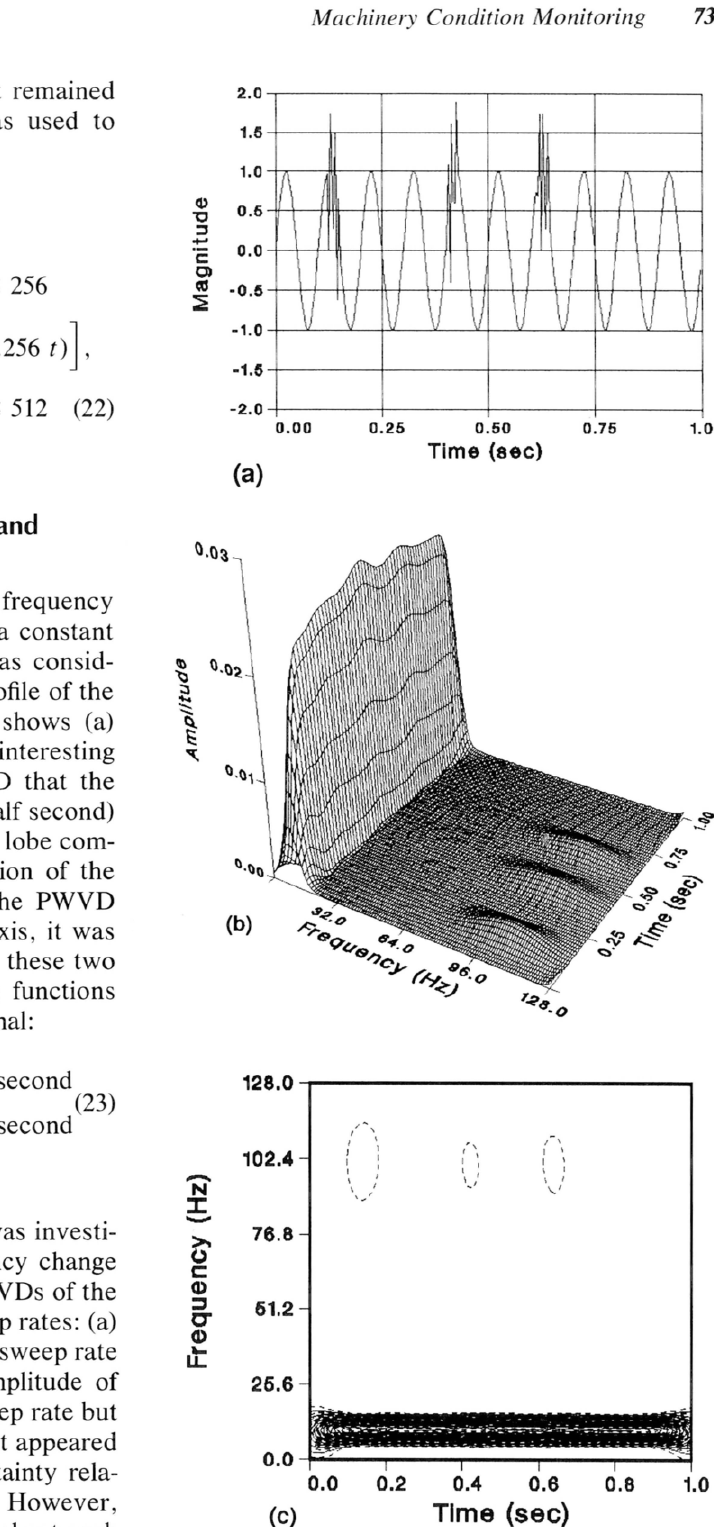
FIGURE 9 Pseudo Wigner-Ville distribution of the signal with glitches. (a) Time signal, (b) PWVD, and (c) the contour plot of the PWVD. Is = 256 Hz, N = 256, smoothing window size = 10 x